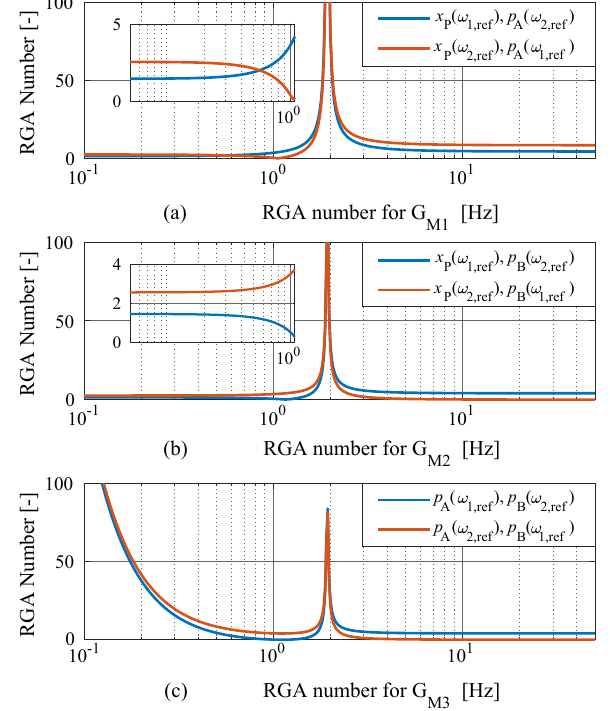
Figure 10: RGA numbers for diagonal and off-diagonal input/output pairings for G and G ( s cM3